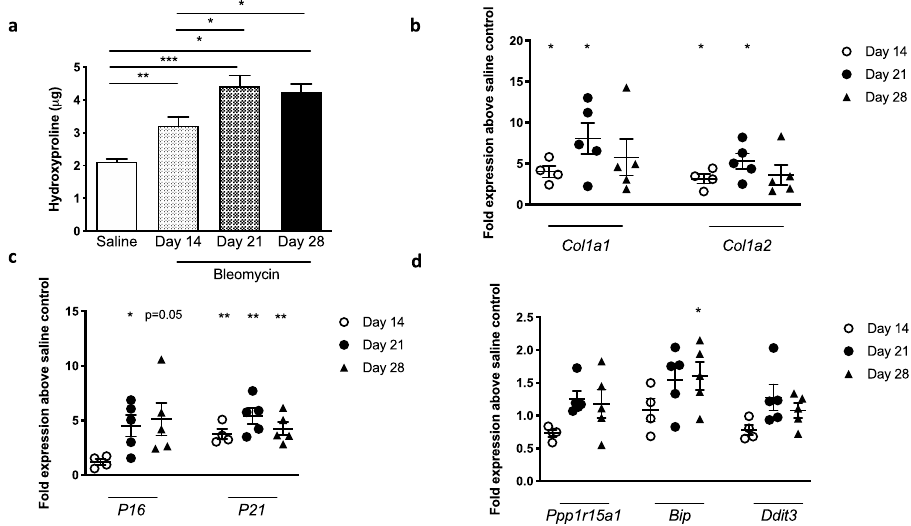
Figure 4. UPR and cellular senescence markers correlate with fibrosis in experimental bleomycin-induced pulmonary fibrosis. ( a ) Hydroxyproline levels in the lungs of C57Bl/6 mice at designated timepoints after oropharyngeal bleomycin challenge (n = 6–8/ group). ( b – d ) Gene expression as measured by RT-PCR of fibrosis-related genes ( b ), senescence associated markers ( c ) and UPR-pathway related genes ( d ) in whole lung tissue following bleomycin challenge as measured as fold change in gene expression in the bleomycin challenged mice in comparison to saline-challenged control mice (n = 4–5 per group). Data are shown as mean ± s.e.m. * P < 0.05, ** P < 0.01, *** P < 0.001 as designated or, when no bars, as compared to saline control